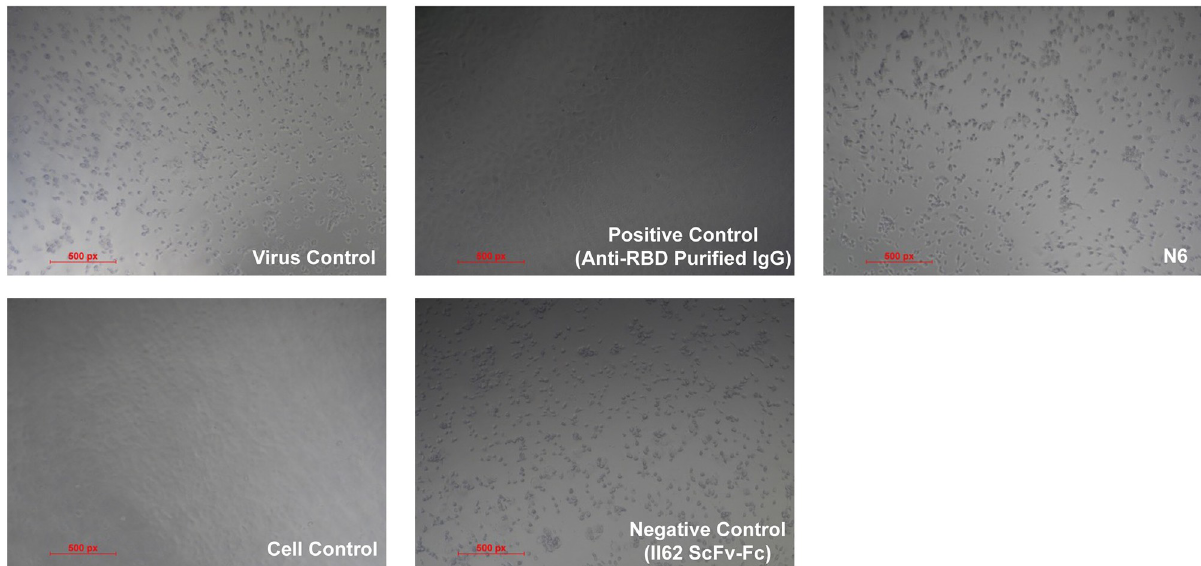
Fig 5. N6 failed to neutralize authentic SARS-CoV-2 virus. A) SARS-CoV-2 infected Vero-E6 cells monolayer after 72 hours post infection is shown as virus control B) Uninfected Vero-E6 cells monolayer after 72 hours showing complete absence of CPE is shown as representative cell control. Incubation of SARS-CoV-2 virus with 20 μ g/ml of C) N6, D) II62 scFv-Fc and E) Anti-RBD IgG respectively, followed by adsorption for 60 minutes on Vero E6 cells. CPE was observed after 72 hours. No significant reduction in the CPE (neutralizing activity) was observed for N6 & II62 mAb which indicates these antibodies did not block SARS-CoV-2 infection. The purified Anti-RBD IgG was used as assay positive control and no CPE was observed (upto 0.1 μ g/ml) which means virus is completely blocked by neutralizing antibodies and did not show infection on Vero-E6 cells Scale, 500px.